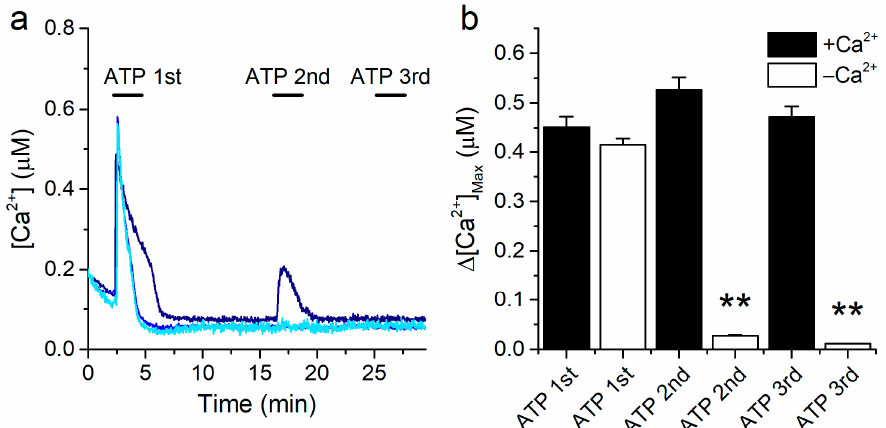
Figure 2. ATP mobilizes Ca 2+ from intracellular stores. ( a ) Examples of traces of [Ca 2+ ] recorded in 16HBE cells showing the effects of repetitive extracellular application of 10 µ M ATP in the absence of extracellular Ca 2+ . ( b ) Amplitude of the responses to the 1st, 2nd and 3rd ATP applications in the presence and in the absence of extracellular Ca 2+ . The data are represented as mean ± s.e.m. ( n = 207, 482, 97, 249, 97 and 247 for the columns from left to right). The asterisks (**) denote statistically significant difference of the data obtained in the Ca 2+ -free condition ( − Ca 2+ ) with respect to the corresponding control data (+Ca 2+ ) ( p < 0.01; Kolmogorov–Smirnov test).